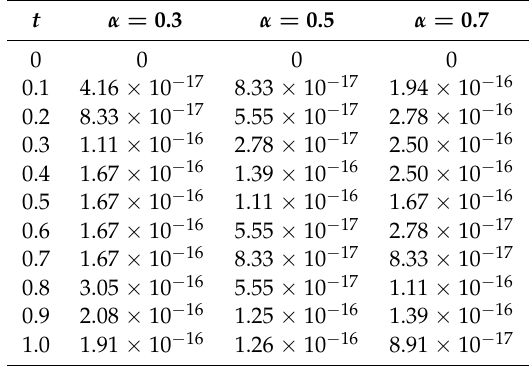
Table 5. The absolute errors with m = 3 and α < 1 for Example 4.